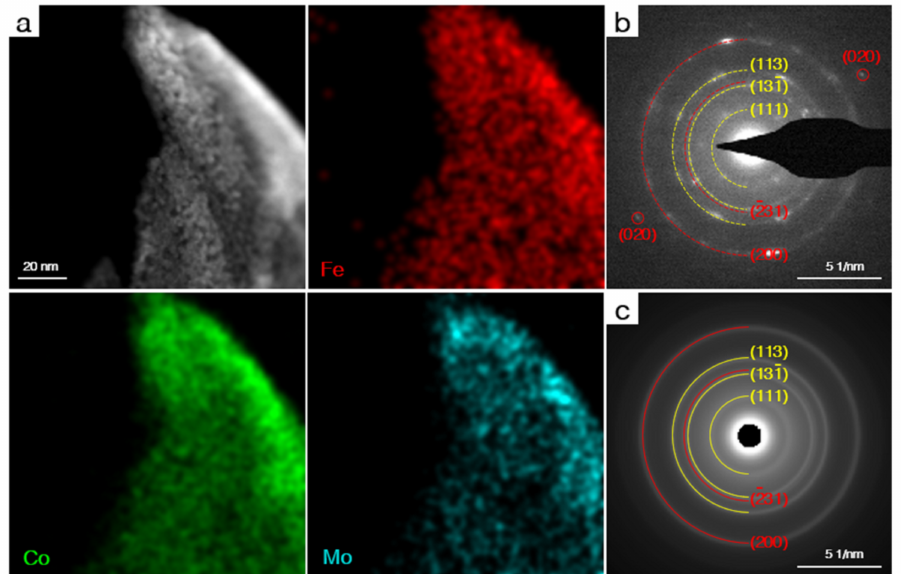
Figure 5. ( a ) HAADF STEM and corresponding EDS mapping images of CoMoO 4 @ γ -FeOOH after LSV test. ( b ) SAED and ( c ) Radially-averaged patterns of CoMoO 4 @ γ -FeOOH after LSV